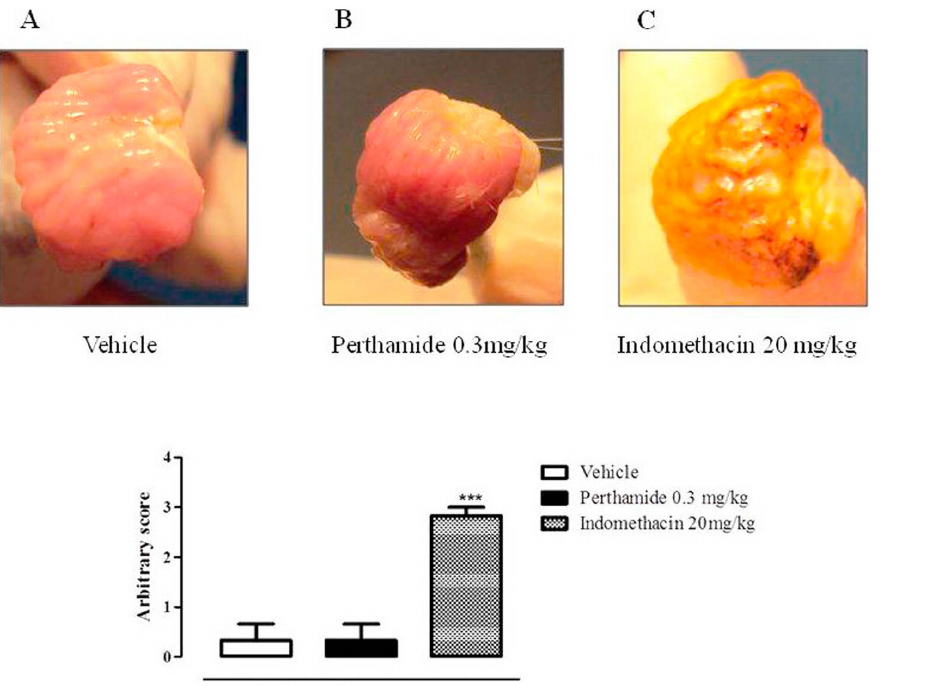
Figure 8. Perthamide C does not possess ulcerogenic action. Blindly arbitrary score was assessed as follows: 0=healthy; 1=hyperemic; 2=lesions without blood; 3 lesions with blood; n=3 for each group indomethacin was used as a control ulcerogenic drug. Pictures are representative of three different animals for each group of treatment.